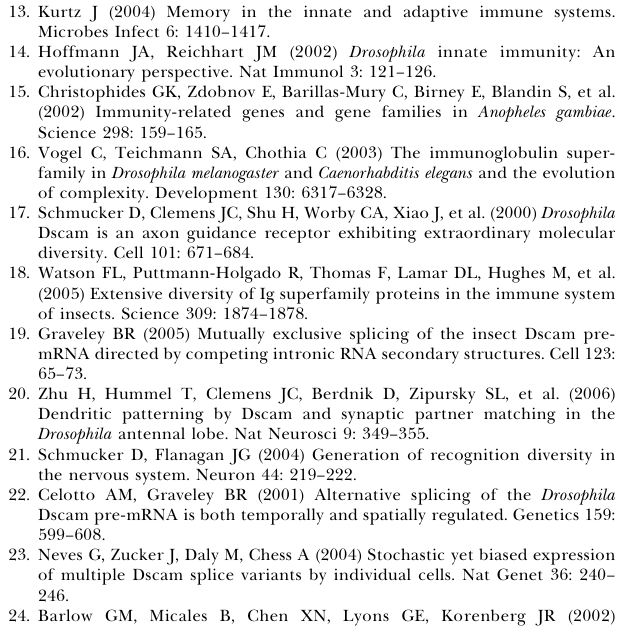
Figure S4. Effect of RNAi Gene Silencing of AgDscam on Parasite Development in Mosquito Midgut CTRL: GFP dsRNA control; AgDscam KD: AgDscam- silenced mosquito. Control and AgDscam- silenced mosquitoes were blood fed from the same mouse infected with the P. berghei GFP, oocysts morphology was observed, and oocysts numbers were counted with fluorescent microscope at day 13 after feeding. Table S1. RTqPCR Analyses of AgDscam Exon 4 Transcripts upon